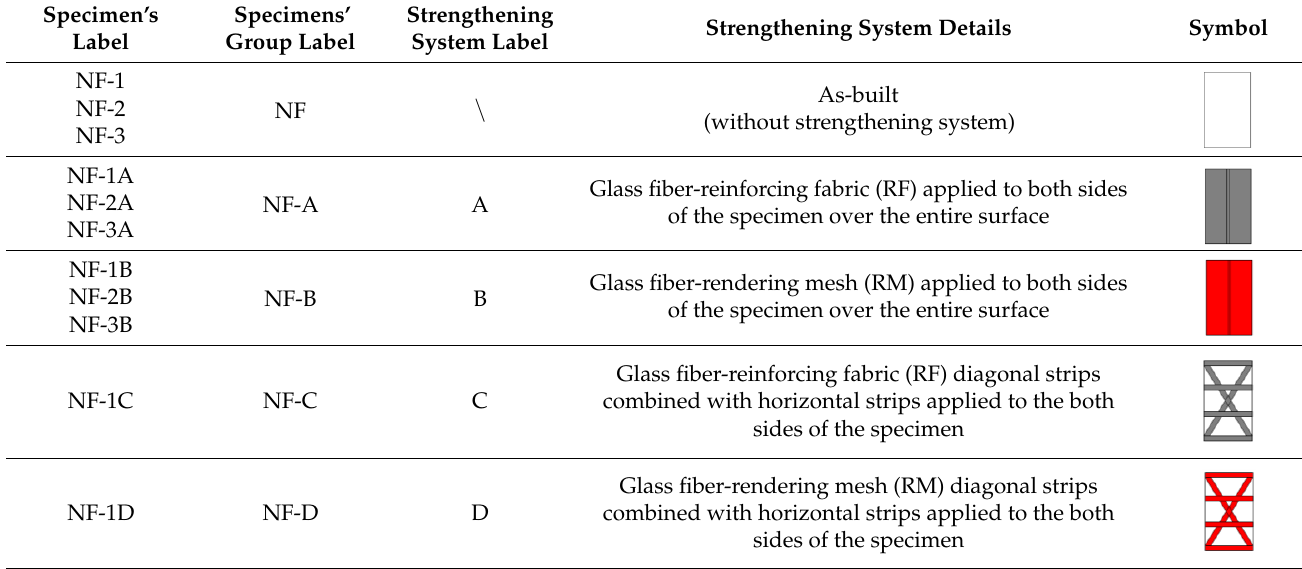
Figure 2. Geometry of applied strengthening systems. Table 1. Matrix of specimens and applied strengthening systems. Table 1. Matrix of specimens and applied strengthening systems. Table 1. Matrix of specimens and applied strengthening systems. Table 1. Matrix of specimens and applied strengthening systems. Table 1. Matrix of specimens and applied strengthening systems. Table 1. Matrix of specimens and applied strengthening